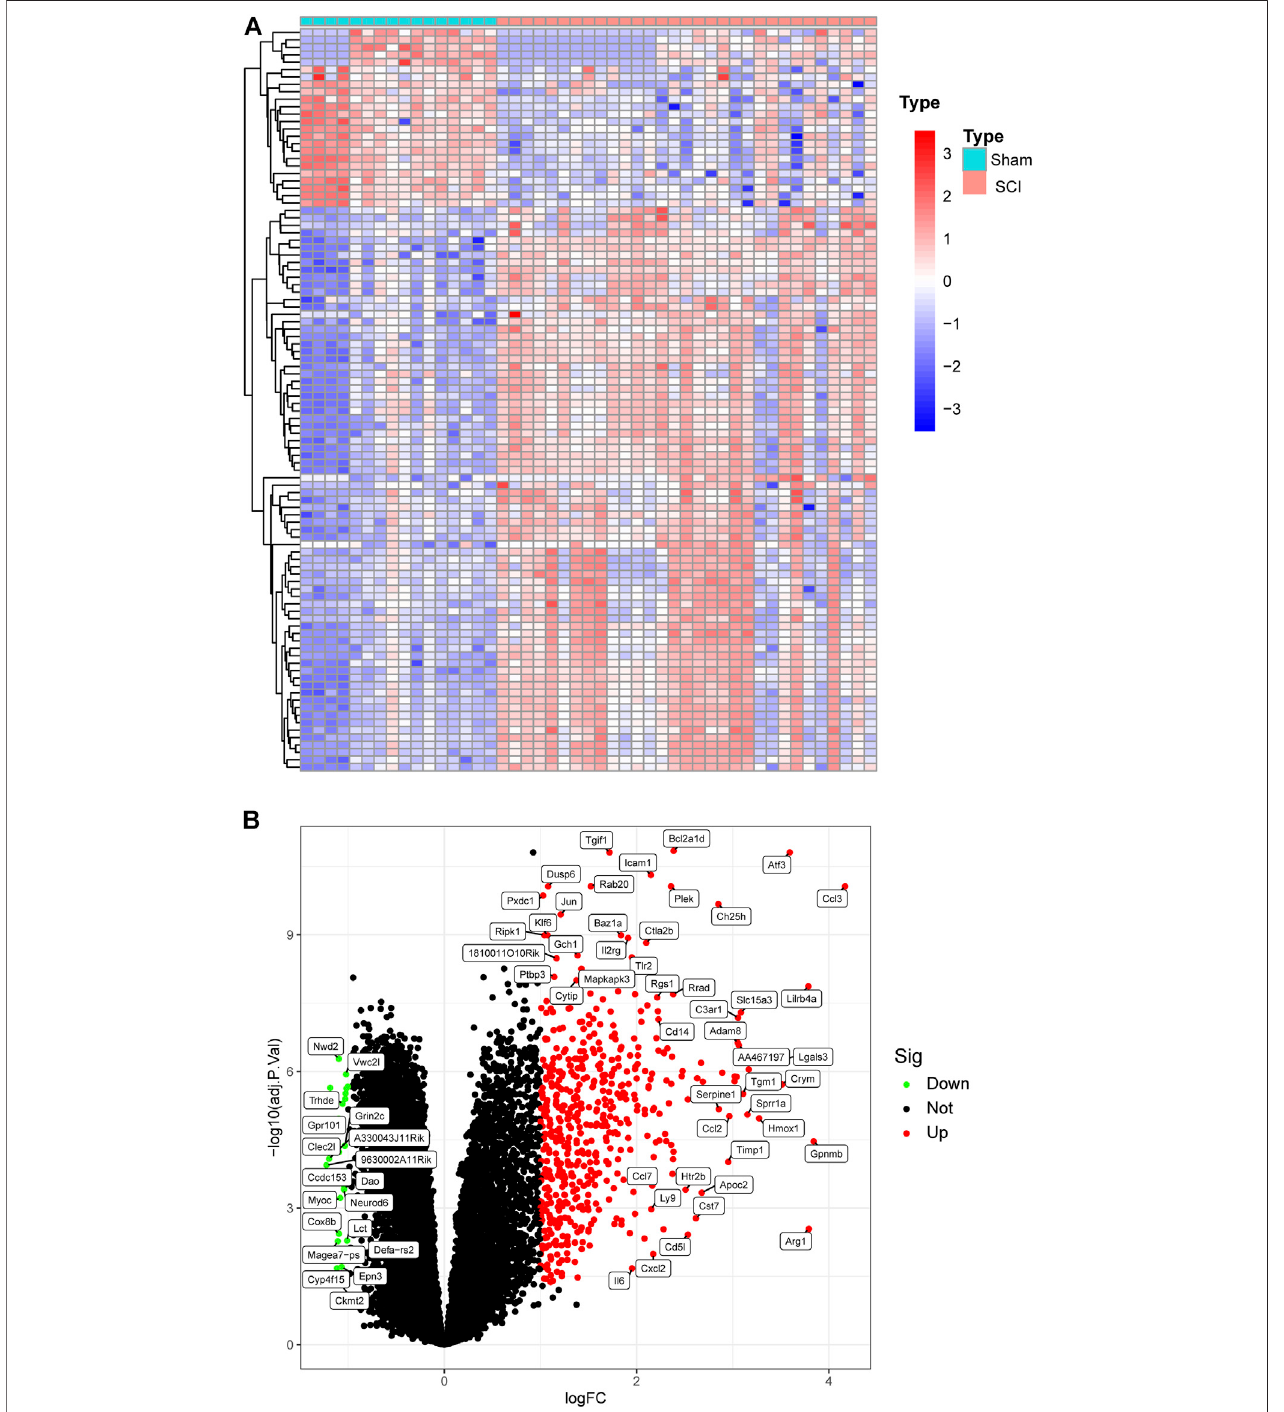
FIGURE 2 | Heat map and Volcano plot of the DEGs. (A) Each row of the heat map represented one DEG, and each column represents one sample. The red and blue colors represent upregulated and downregulated DEGs, respectively. (B) Red points represented upregulated DEGs, and green points displayed downregulated